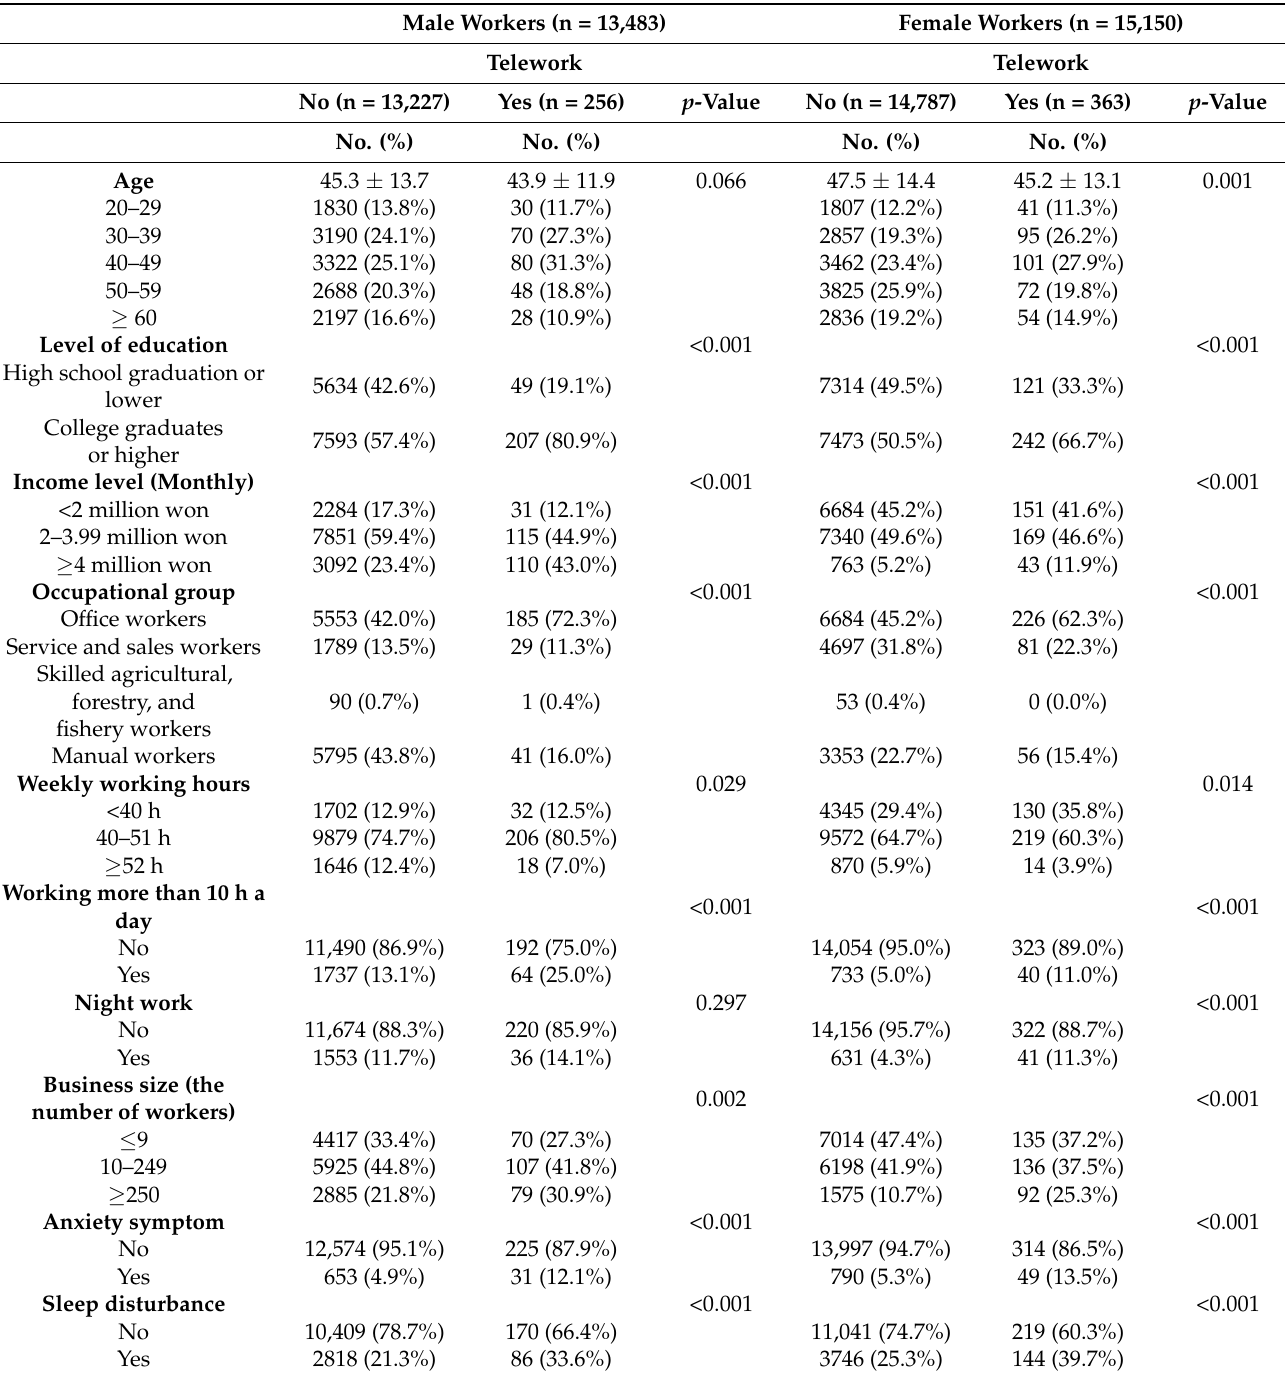
Table 1. Characteristics of male and female participants by telework. Male Workers (n =